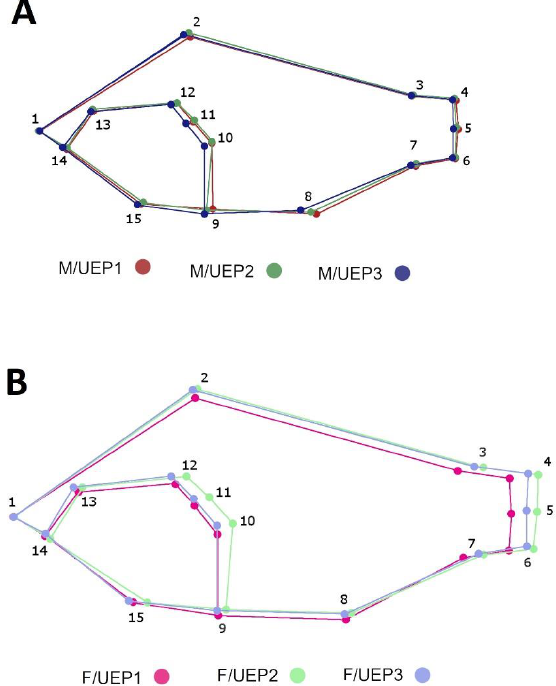
Figure 5. Average shape superposition of Caquetaia kraussi represented by colored wireframe between sexes and localities. ( A ): Male Wireframe Overlay. red: male UEP1; dark green: male UEP2 and dark blue: male UEP4. ( B ): Female’s wireframe overlay. Pink: female UEP1; light green: female UEP2 and light blue: female UEP4.